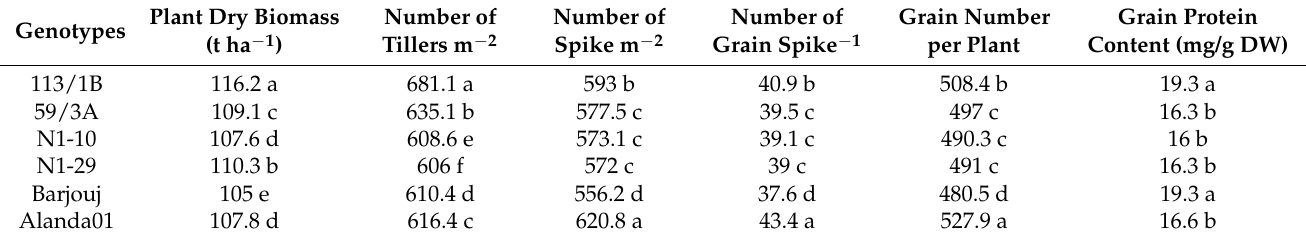
Table 4. Barley genotype difference in biomass and agro-physiological traits across all salinity